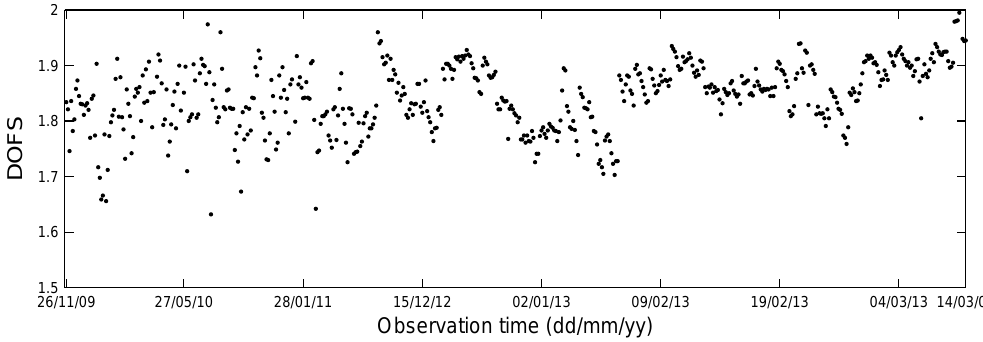
Figure 2. Degrees of freedom for signal for all FTIR measurements at Addis Ababa.